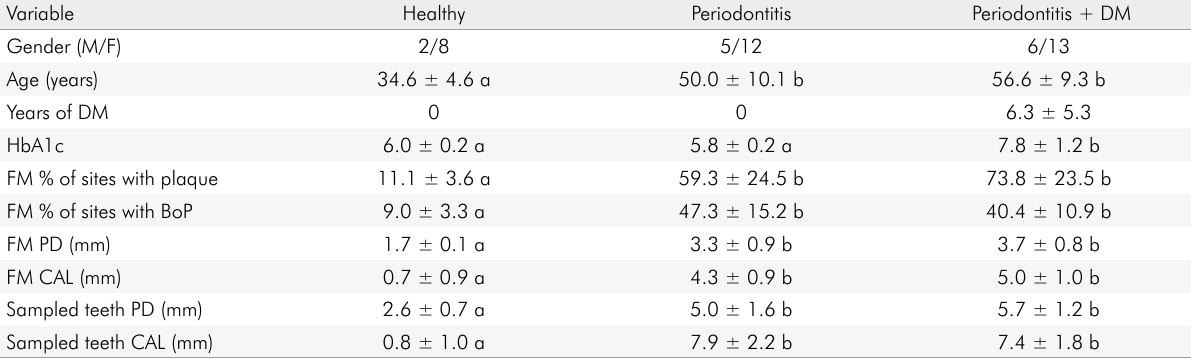
Table 2. Demographic characteristics, glycaemic and periodontal parameters (mean ± SD).